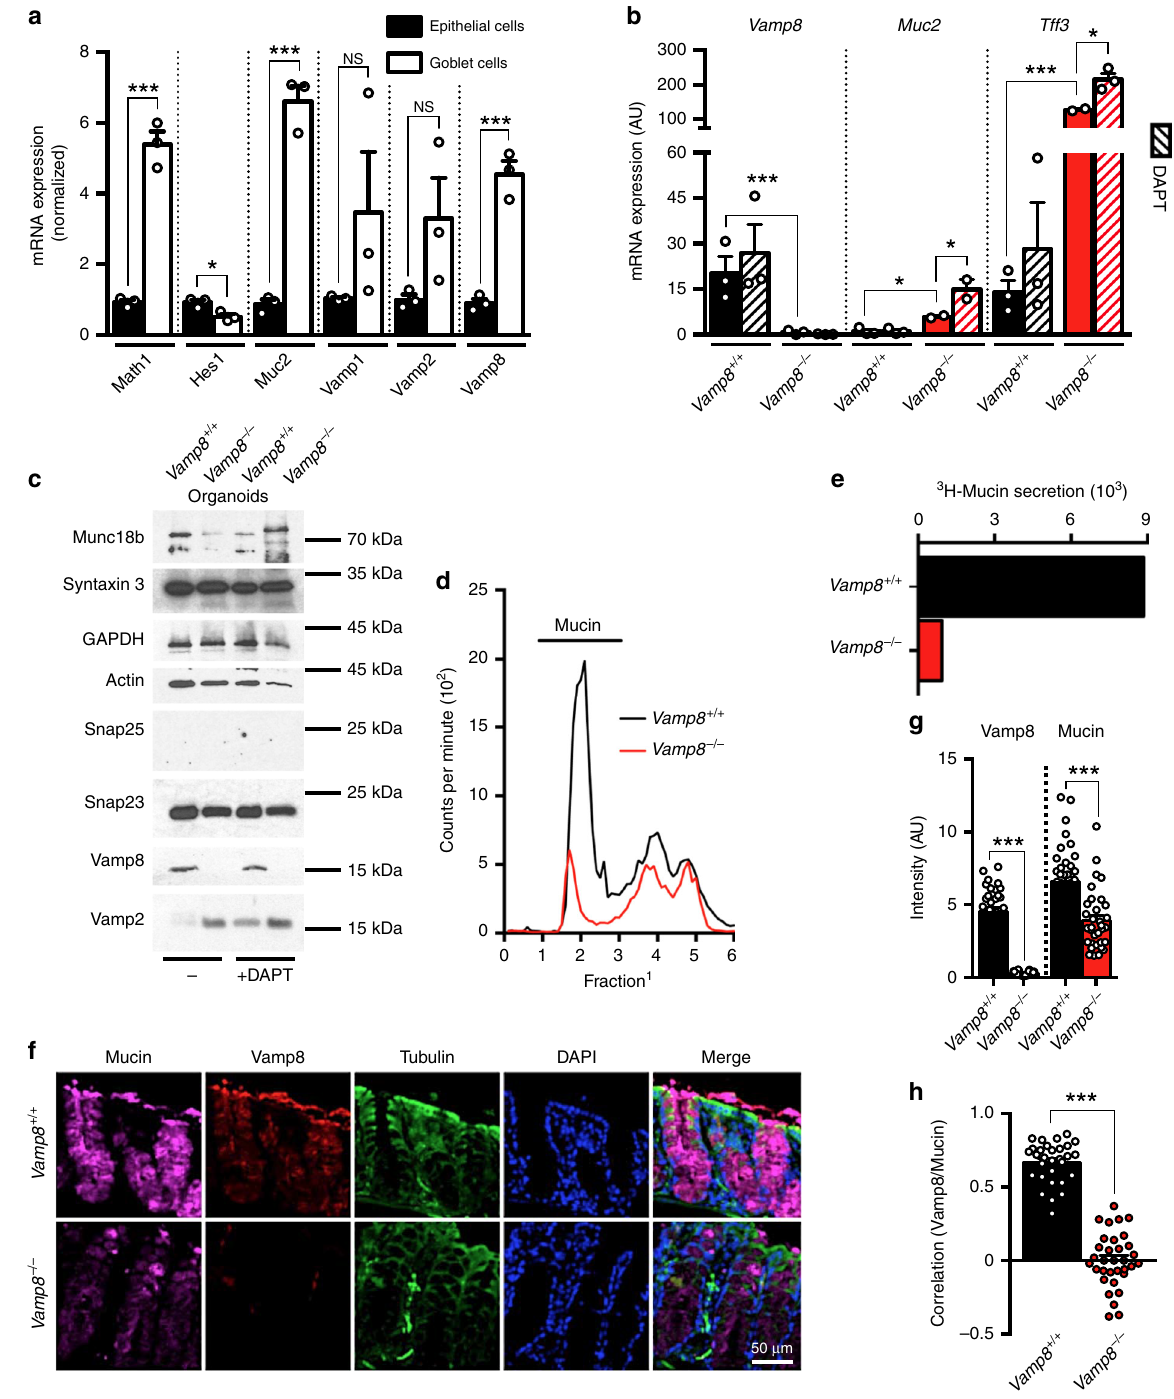
surface mucosa (Fig. 2d) and goblet cell integrity and organiza- tion, where entire mucin granules were observed in the lumen indicative of non-classical secretion mechanisms (Fig.